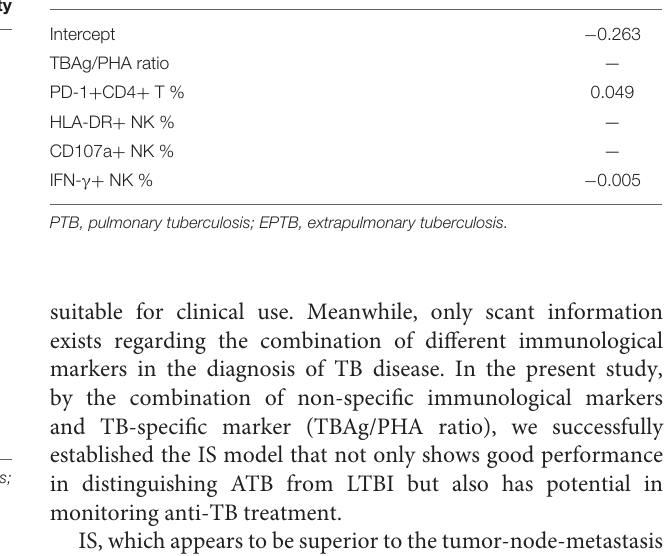
TABLE 3 | IS model for discrimination between ATB and LTBI.